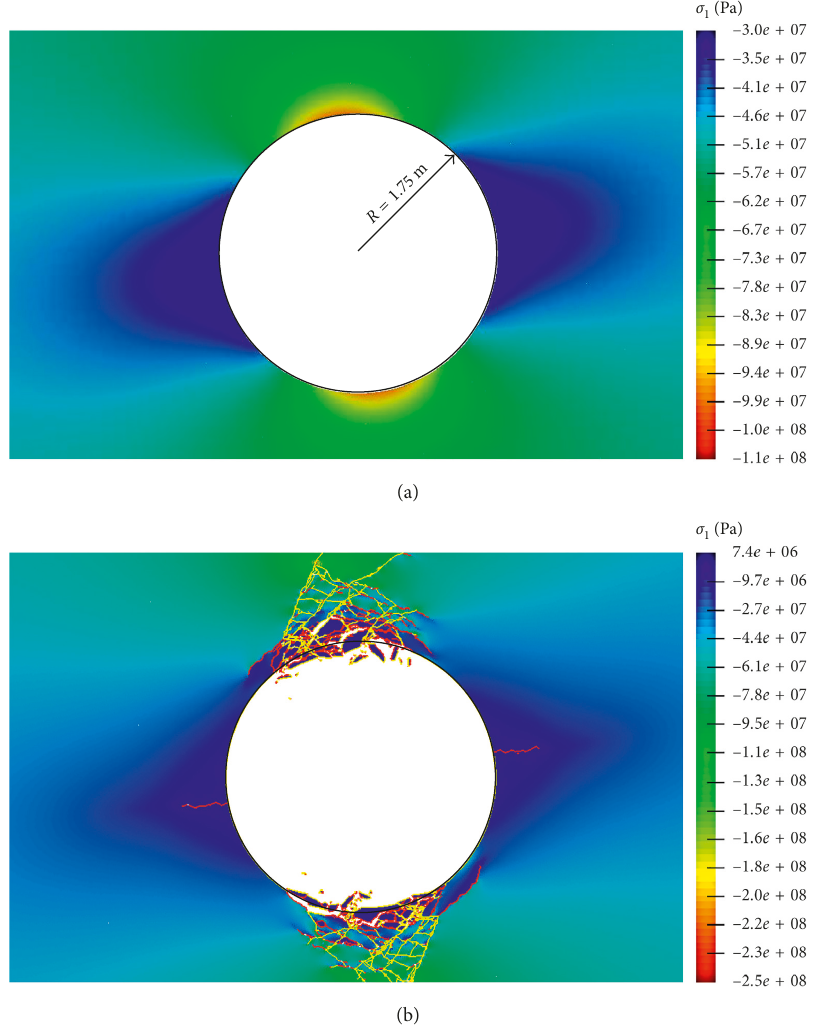
Figure 9: Major principal stress 1 contours of the intact FDEM model. (a) Elastic response of the model at 60% of the induced stresses (tunnel advancing), and (b) final model state after the completion of the excavation. Cohesive elements failing in tension (Mode I fractures) are coloured red, and cohesive elements failing in shear (Mode II fractures) are coloured σ